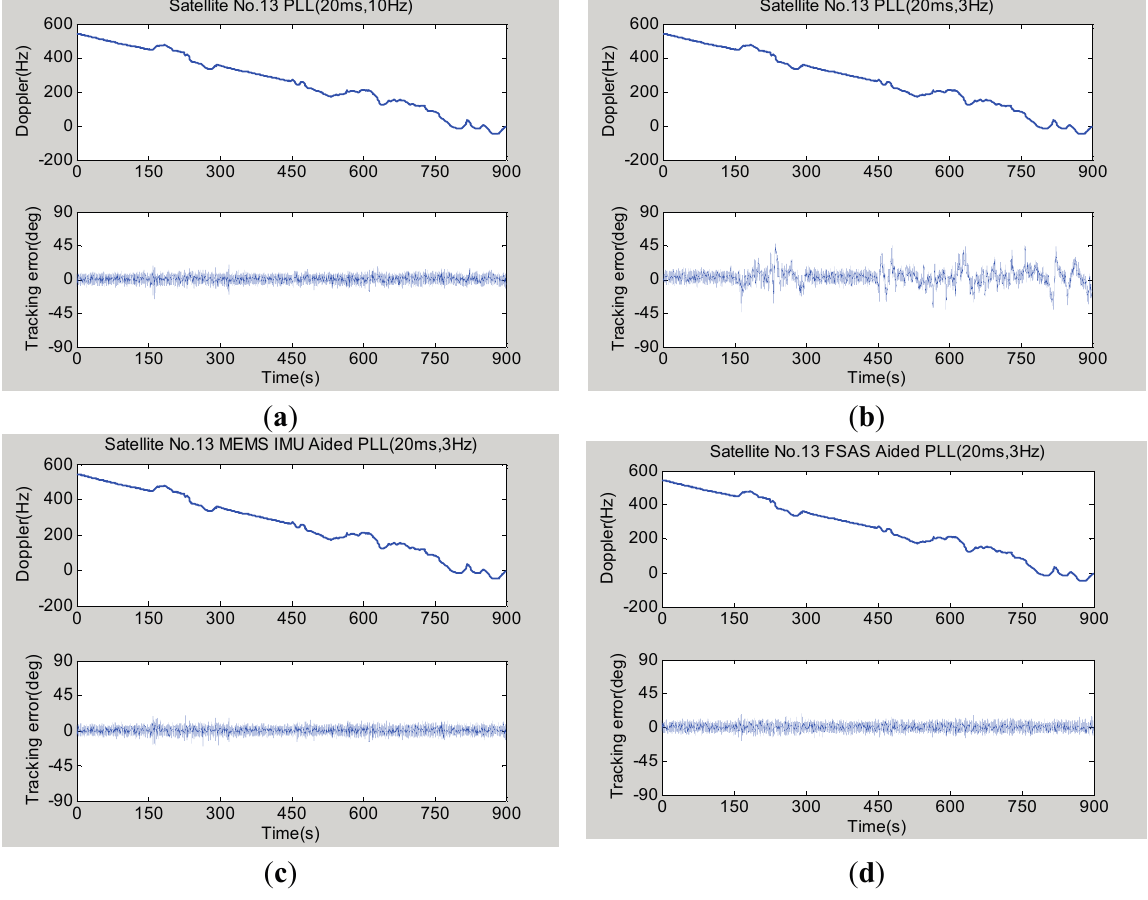
Figure 18. GNSS carrier phase tracking error testing based on the real vehicle test. ( a ) Normal PLL (20 ms, 10 Hz); ( b ) normal PLL (20 ms, 3 Hz); ( c ) MEMS INS-aided PLL (20 ms, 3 Hz); ( d ) medium-grade INS-aided PLL (20 ms, 3